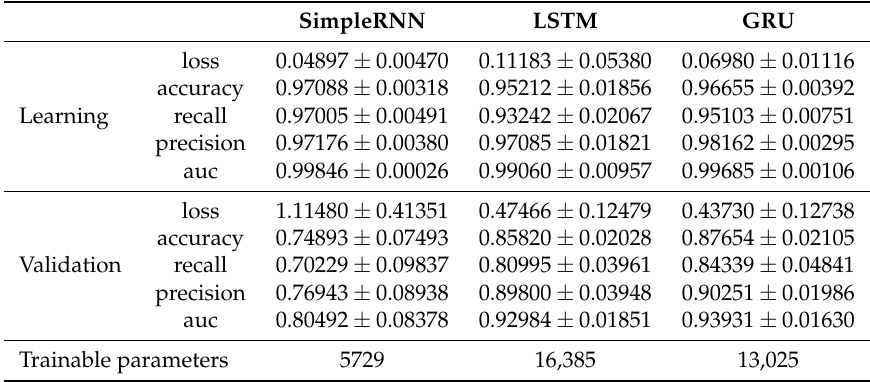
Table 2. Recurrent models mean metrics with standard